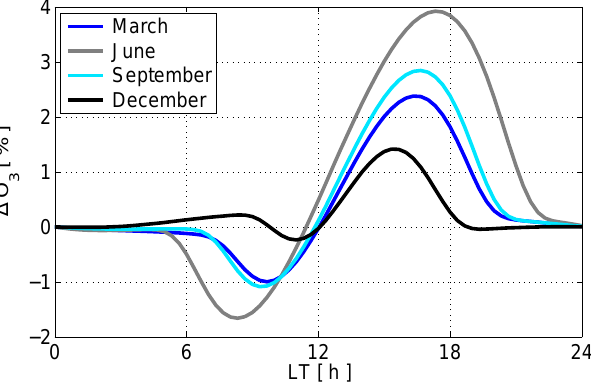
Figure 2. Temporal evolution and seasonal diversity of the daily ozone cycle at 50 ◦ N. The data are zonal means modelled by WACCM at 5hPa. The lines show changes in ozone in monthly means of March, June, September and December relative to the midnight value of